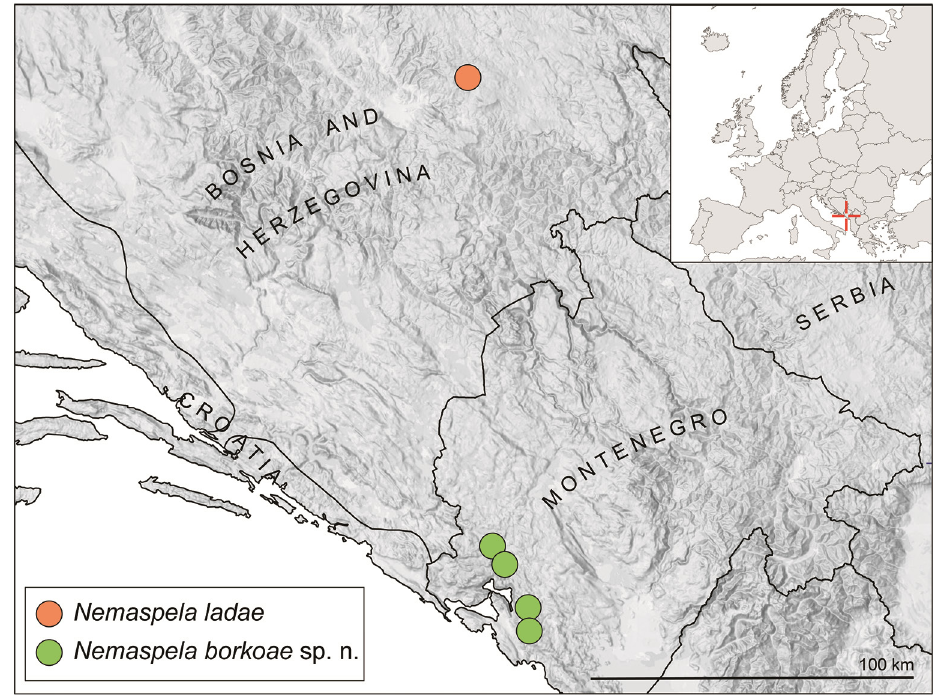
Fig. 6. Distribution of species of Nemaspela Šilhavý, 1966 in the Balkans. The locality for N . ladae Karaman, 2013 from Karaman